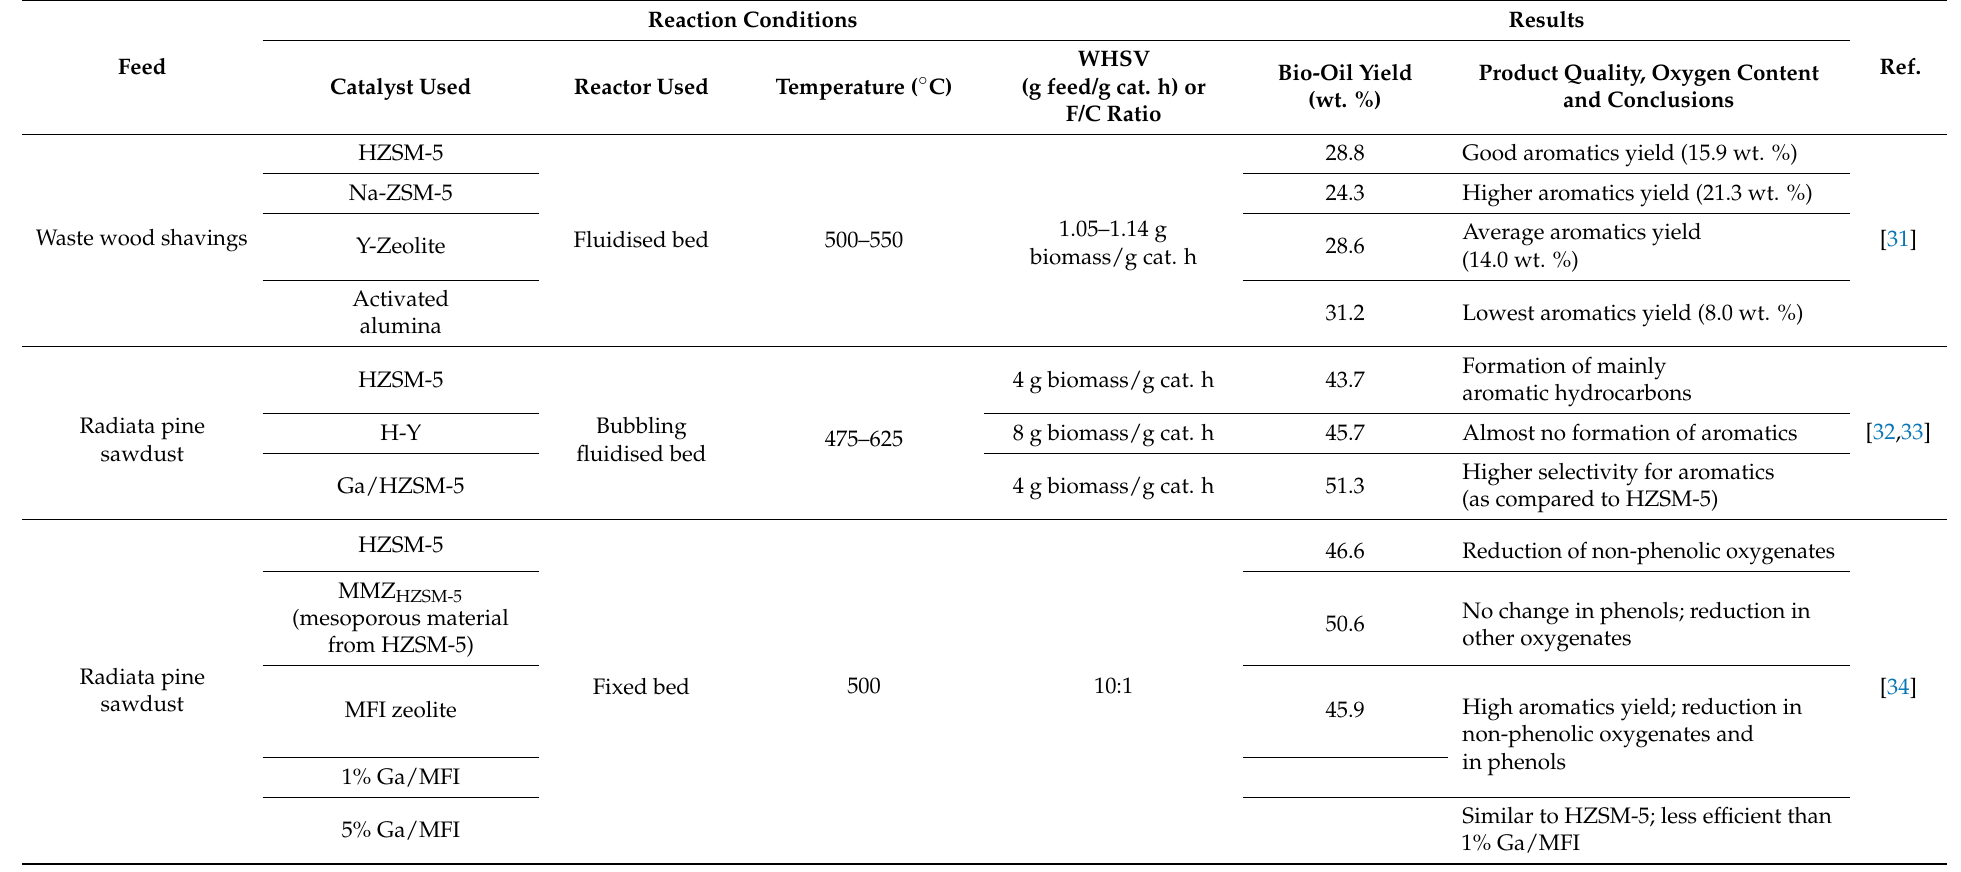
Table 3. Notable research works on CFP using zeolite-based